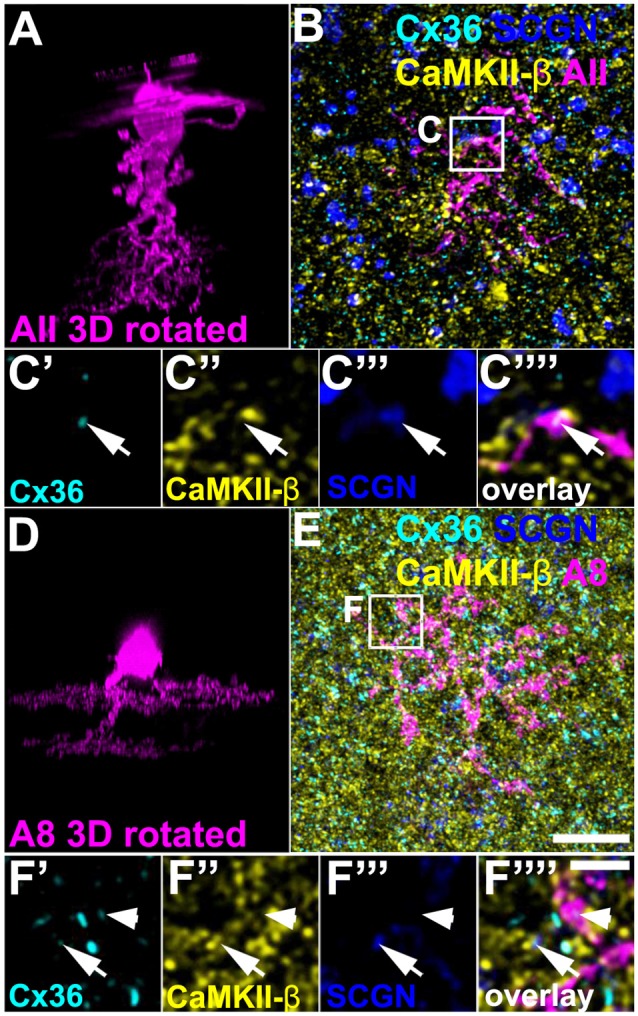
CaMKII-β was absent from gap junctions that AII and A8 amacrine cells form with bipolar cells. (A) XZ rotation of an Alexa568-injected AII amacrine cell. Please note that the “whirl” around the soma represents an injection artifact. (B) Maximum projection (20 optical sections) of the injected cell, labeled for CaMKII-β, Cx36, and SCGN. (C’–C””) Colocalization of Cx36 and SCGN was associated with processes of the injected AII amacrine cell but not with CaMKII-β immunoreactivity. (D–F””) Same as (A–C””) but showing an Alexa568-injected A8 amacrine cell. Colocalization of Cx36 and CaMKII-β (indicated by arrows) was not associated with processes of the injected A8 amacrine cell. Cx36 immunoreactivity on the A8 dendrite was not associated with CaMKII-β (arrowhead). Scale: (A,B,D,E), 10 μm; (C’–C””,F’–F””), 2.5 μm.